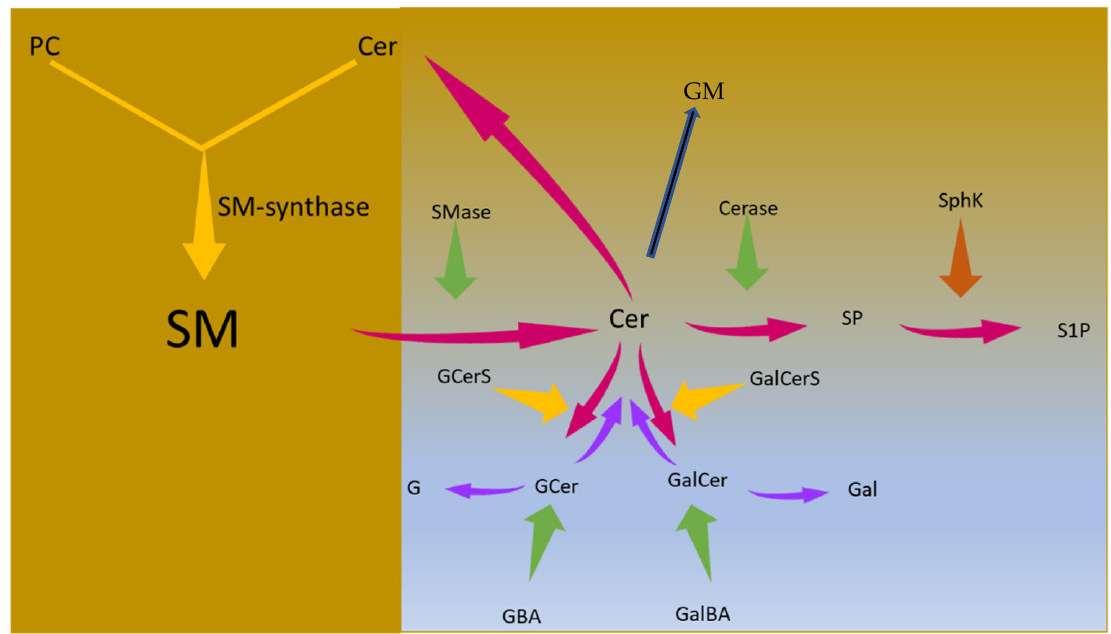
Figure 1. Sphingomyelin metabolism in the brain. Description in the text. SM, sphingomyelin; PC, phosphatidylcholine; Cer, ceramide; SMase, sphingomyelinase; Cerase, ceramidase; SphK, sphingosine kinase; SP, sphingosine, S1P, sphingosine-1-phosphate; GCerS, glucosylceramide synthase; GalCerS, galactosylceramide synthase; GCer, glucosylceramide; GalCer, galactosylceramide; GBA, glucocerebrosidase; GalBA galactocerebrosidase; G, glucose; Gal, galactose.; GM, ganglioside. The yellow arrows indicate the metabolic syntheses; the amaranth red arrows represent the production of Cer from SM and its utilization; the green arrows indicate enzymes with degradation function and the orange arrow an enzyme with phosphorylation function; the purple arrows indicate the effect of GBA and GalBA, i.e., production of Cer and G or Gal; the blue arrow indicates the use of Cer to synthesise GM